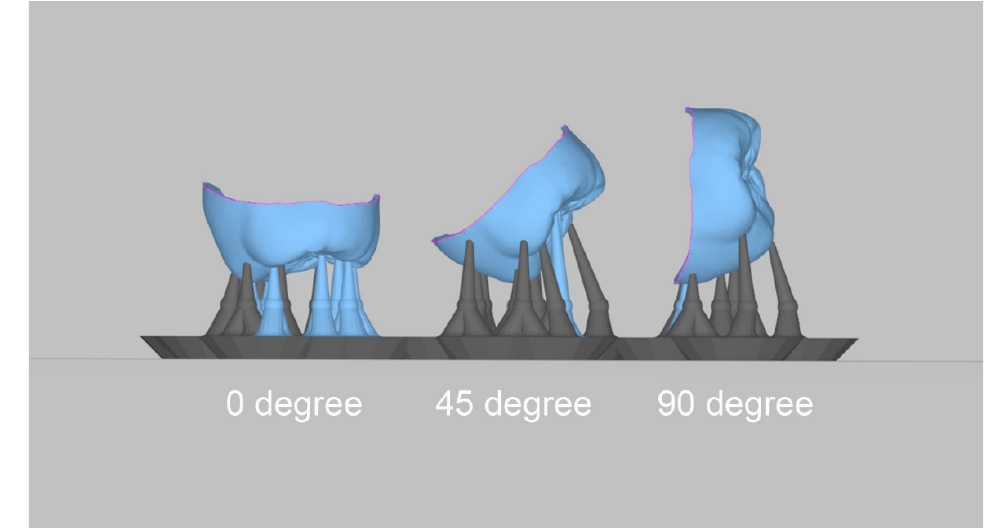
Figure 2. Digital light processing 3D-printing build angles.